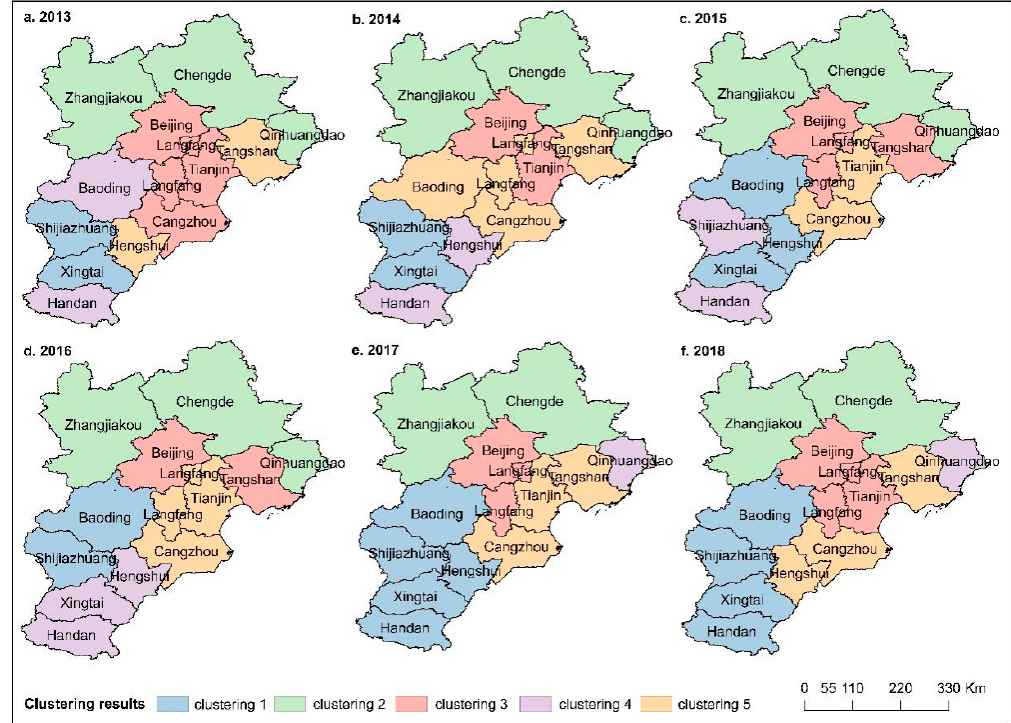
Figure 7. The clustering distribution of PM 2.5 for BTH from 2013–2018. Each cluster is denoted by a unique